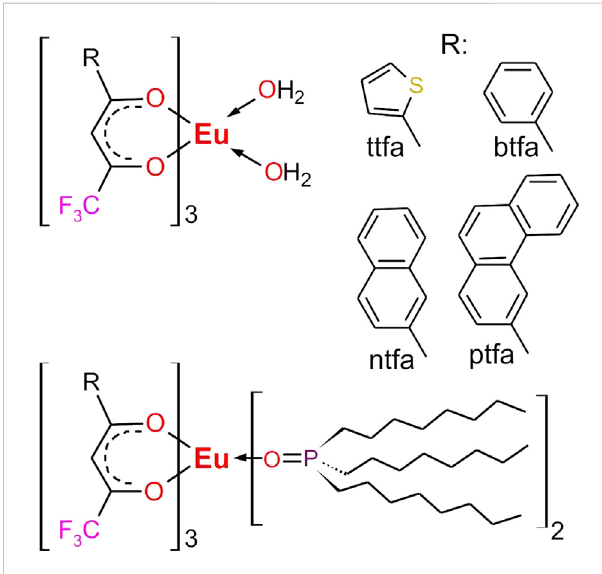
FIGURE 1 Complexes under investigation for incorporation into polystyrene beads. R = ttfa, 1-(2-thienyl)-4,4,4-tri fl uoro-1,3-butandion, btfa = 1- phenyl-4,4,4-tri fl uoro-1,3-butandion, ntfa = 2-naphthyl-4,4,4- tri fl uoro-1,3-butandion, ptfa =3-phenanthryl-4,4,4-tri fl uoro-1,3- butandion.